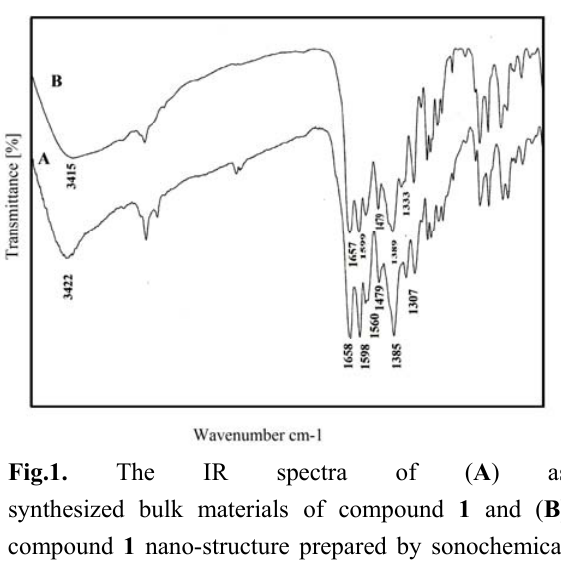
Fig.1. The IR spectra of ( A ) as synthesized bulk materials of compound 1 and ( B ) compound 1 nano-structure prepared by sonochemical